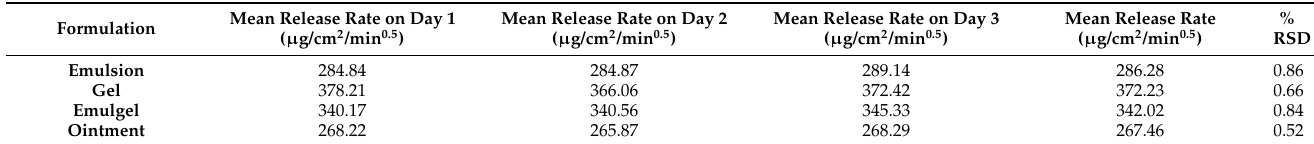
( µ g/cm 2 /min 0.5 ) and % RSD for six replicates.